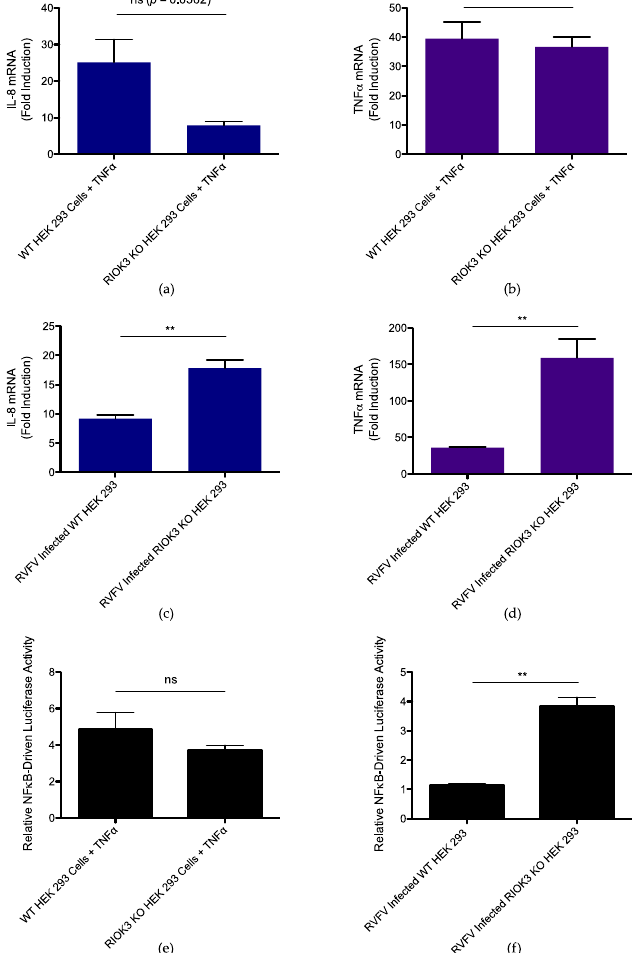
Figure 3. Effect of RIOK3 KO on inflammatory cytokine transcription during TNF α treatment or RVFV infection. ( a ) IL-8 mRNA expression in WT vs. RIOK3 KO cells treated with 20 ng/mL TNF α for 4 h. ( b ) TNF α mRNA expression in WT vs. RIOK3 KO cells treated with 20 ng/mL TNF α for 4 h. ( c ) IL-8 mRNA expression in WT vs. RIOK3 KO cells infected with RVFV MP12 at an MOI ~1. ( d ) TNF α mRNA expression in WT vs. RIOK3 KO cells infected with RVFV MP12 at an MOI ~1. ( e ) Luciferase assay measuring NF κ B promoter activity in WT vs. RIOK3 KO HEK 293 cells treated with 20 ng/mL TNF α for 4 h. Fold induction is relative to negative control values from respective cell types (WT or RIOK3 KO) that were not treated with TNF α . ( f ) Luciferase assay measuring NF κ B promoter activity in WT vs. RIOK3 KO HEK 293 cells infected with RVFV at an MOI ~2. Fold induction is relative to negative control values from respective cell types (WT or RIOK3 KO) that were mock-infected. In ( a , b ), cells were grown in 12-well plates and seeded at a density ~0.1 × 10 6 cells/well, and fold induction is relative to expression values of respective cell types that were not